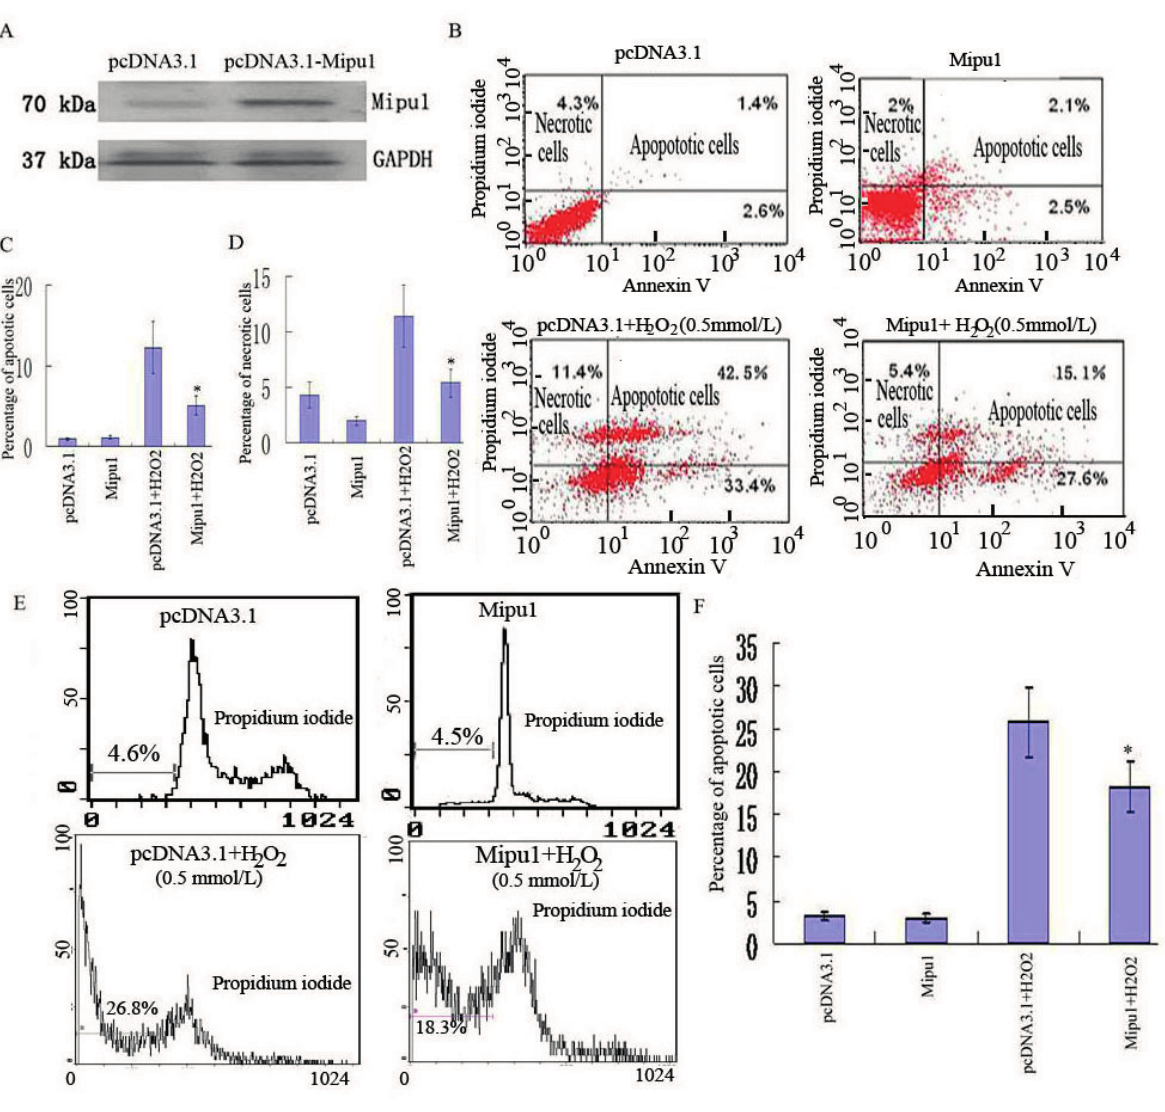
Figure 3. Over-expression of Mipu1 inhibited apoptosis induced by H 2 O 2 in H9c2 myogenic cells. ( A ) H9c2 myogenic cells were transfected with pcDNA3.1-Mipu1 and the expression level of Mipu1 was determined by Western blotting assay; ( B ) The percentage of apoptotic cells was determined by Annexin V and propidium iodide staining and flow cytometry; ( C ) Statistical analysis of the flow cytometry data of apoptotic cells; ( D ) Statistical analysis of the flow cytometry data of necrotic cells; ( E ) The percentage of apoptotic cells was determined by propidium iodide staining and flow cytometry; ( F ) Statistical analysis of the flow cytometry data of apoptotic cells. pcDNA3.1: the vector control group; Mipu1: Mipu1 over-expression group. Values represent the mean ± SEM. *, vs. pcDNA3.1 + H 2 O 2 group, p < 0.05, n =